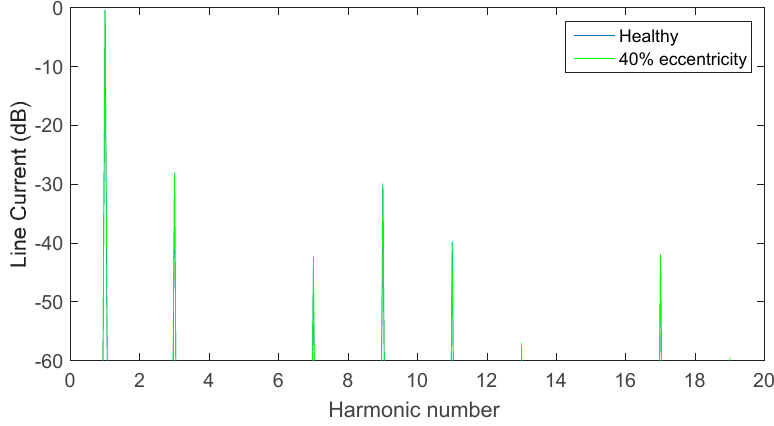
Figure 7. Low-current low-saturation operating conditions. Spectral content of the line currents. Healthy machine and faulty machine with 40% eccentricity.